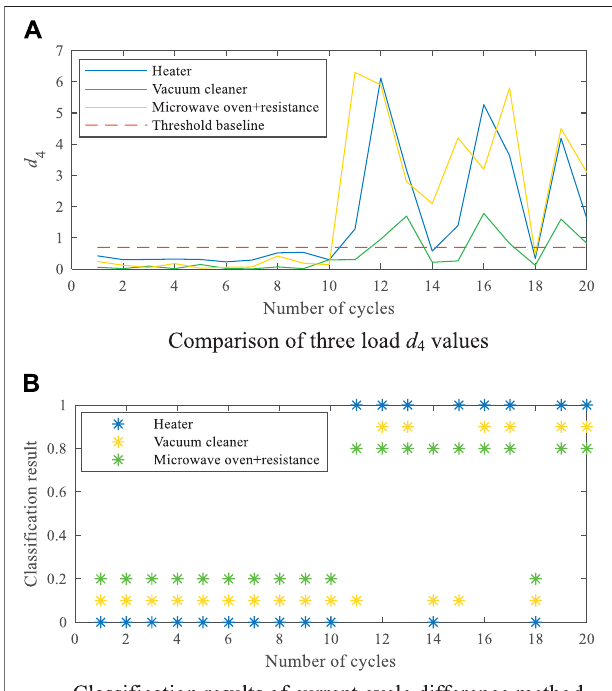
FIGURE12 | Detection effect of the current cycle difference method. (A) Comparison of three load d4 values. (B) Classi fi cation results of the current cycle difference method.